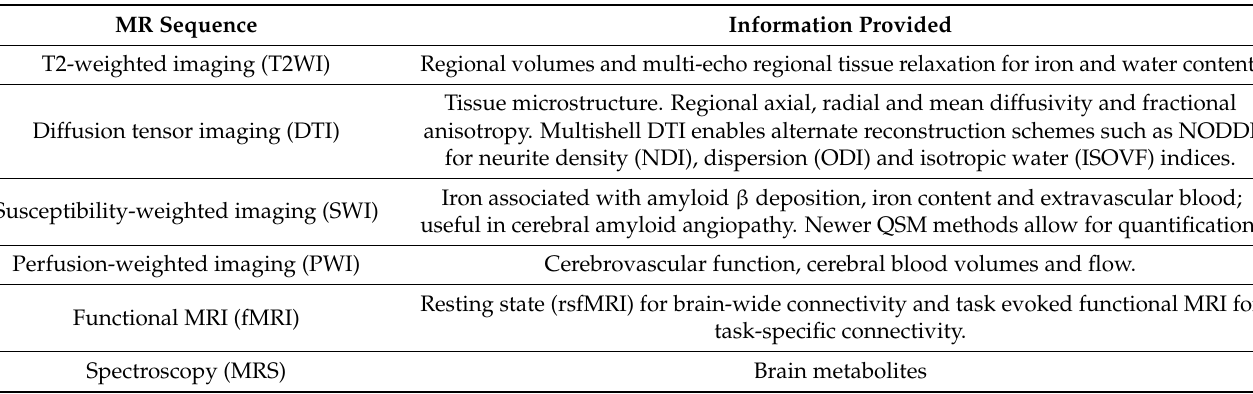
Table 1. Magnetic resonance imaging contrasts available for preclinical AD research. MR Sequence Information Provided Regional volumes and multi-echo regional tissue relaxation for iron and water content. Tissue microstructure. Regional axial, radial and mean diffusivity and fractional anisotropy. Multishell DTI enables alternate reconstruction schemes such as NODDI for neurite density (NDI), dispersion (ODI) and isotropic water (ISOVF) indices. Iron associated with amyloid β deposition, iron content and extravascular blood; useful in cerebral amyloid angiopathy. Newer QSM methods allow for